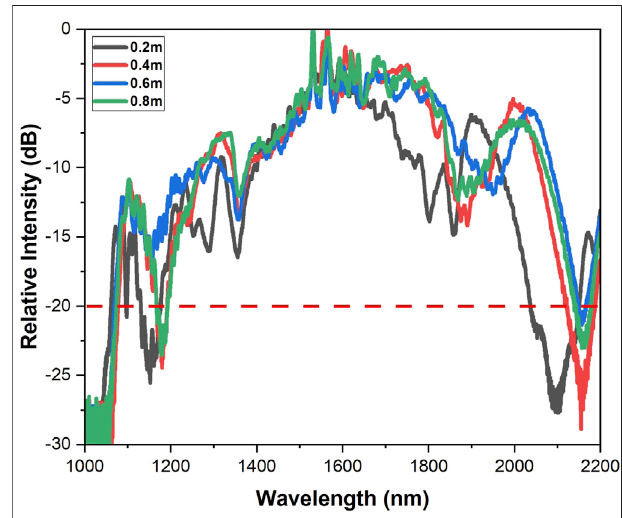
FIGURE 8 | The SC is generated in the hybrid HNLF with 0.2 m zero dispersion and positive dispersion fi ber of varying